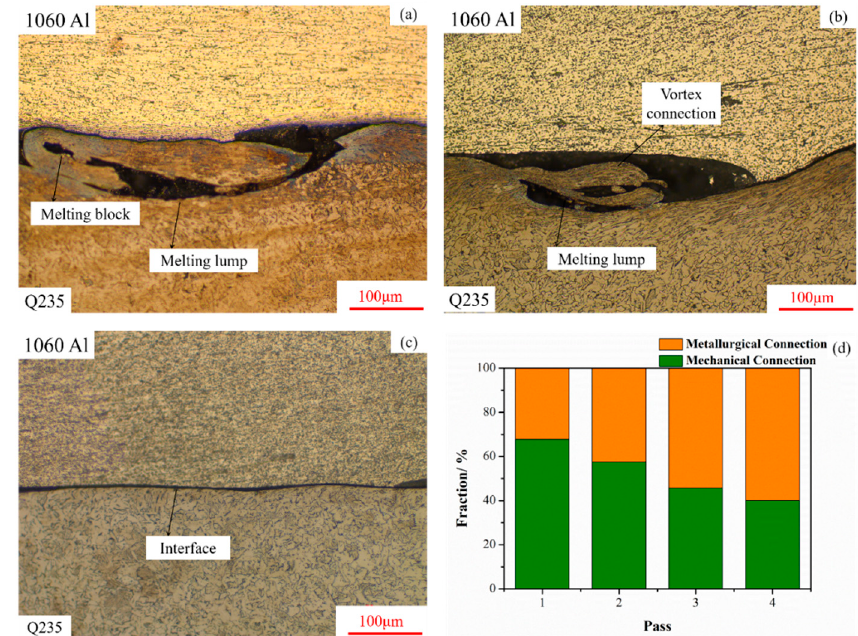
Figure 6. Interface connection mechanism of composite plate: ( a ) hook connections; ( b ) vortex connections; ( c ) metallurgical bondings; ( d ) Fractions for mechanical connections and metallurgical bondings to the interface of composite plate after FSP with different passes.